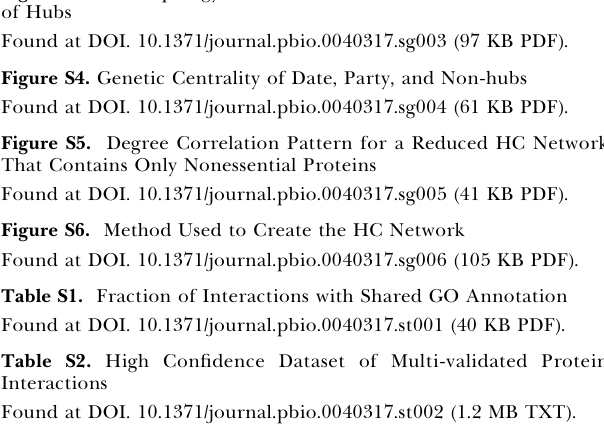
Figure S1. Degree Correlation for HC h and HC m Networks Found at DOI. 10.1371/journal.pbio.0040317.sg001 (120 KB PDF). Figure S2. The Topology of the LC and LC fyi Networks Is Not Sensitive to Deletion of Date or Party Hubs Found at DOI. 10.1371/journal.pbio.0040317.sg002 (122 KB PDF). Figure S3. The Topology of the HC Network Is Sensitive to Deletion of Hubs Found at DOI. 10.1371/journal.pbio.0040317.sg003 (97 KB PDF). Figure S4. Genetic Centrality of Date, Party, and Non-hubs Found at DOI. 10.1371/journal.pbio.0040317.sg004 (61 KB PDF). Figure S5. Degree Correlation Pattern for a Reduced HC Network That Contains Only Nonessential Proteins Found at DOI. 10.1371/journal.pbio.0040317.sg005 (41 KB PDF). Figure S6. Method Used to Create the HC Network Found at DOI. 10.1371/journal.pbio.0040317.sg006 (105 KB PDF). Table S1. Fraction of Interactions with Shared GO Annotation Found at DOI. 10.1371/journal.pbio.0040317.st001 (40 KB PDF). Table S2. High Confidence Dataset of Multi-validated Protein Interactions Found at DOI. 10.1371/journal.pbio.0040317.st002 (1.2 MB